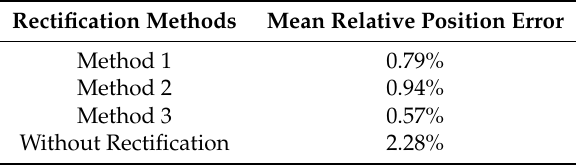
Table 2. Error comparison of three rectification methods.